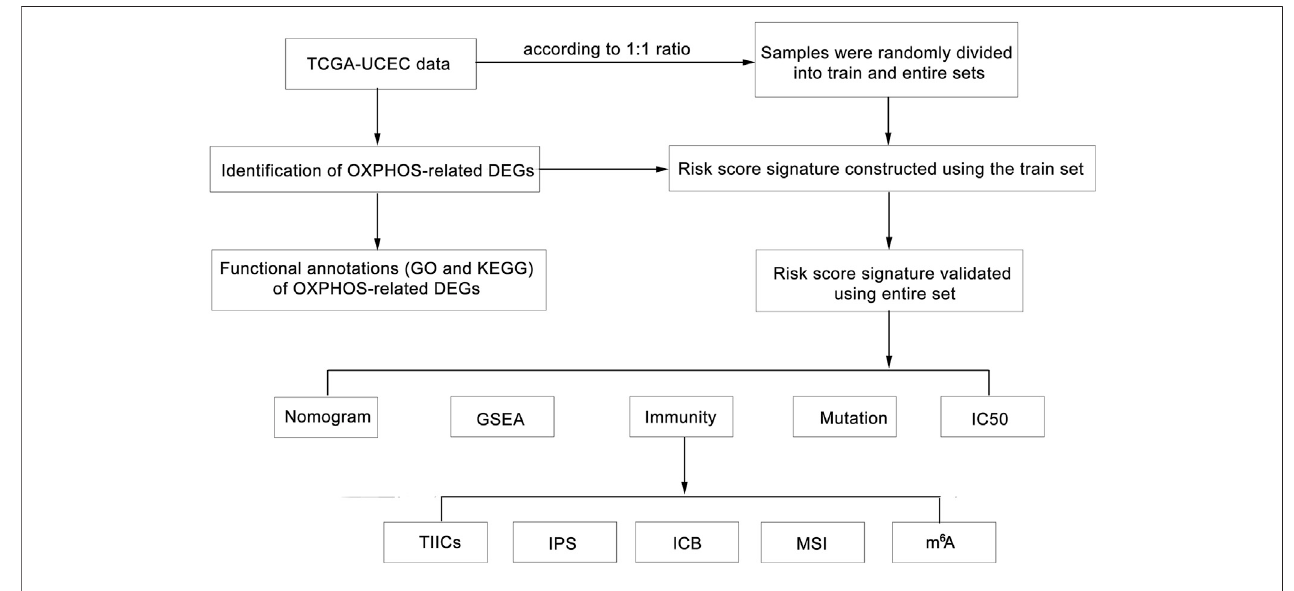
FIGURE 1 | Flow chart of the bioinformatic analyses.